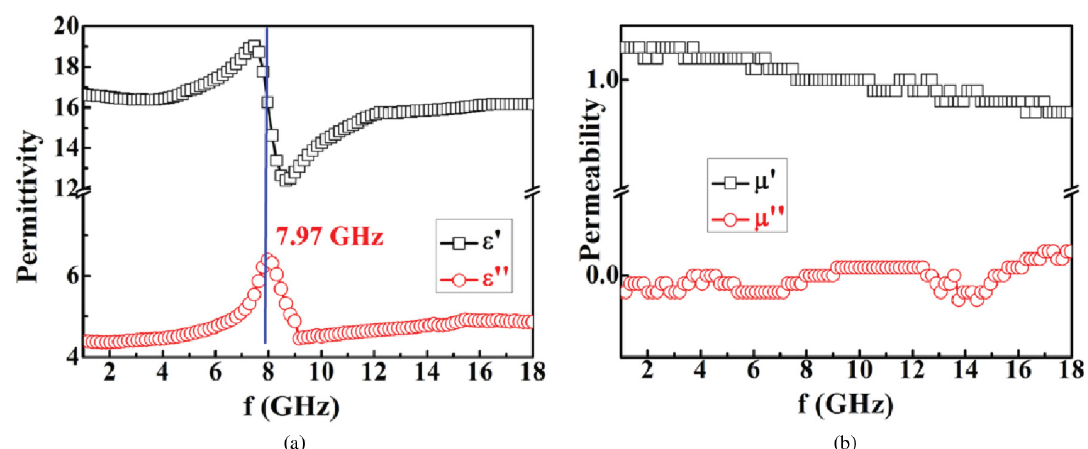
Figure 2. (a) Relative permittivity and (b) relative permeability of paraffin-Cu nanocapsules composite as a function of